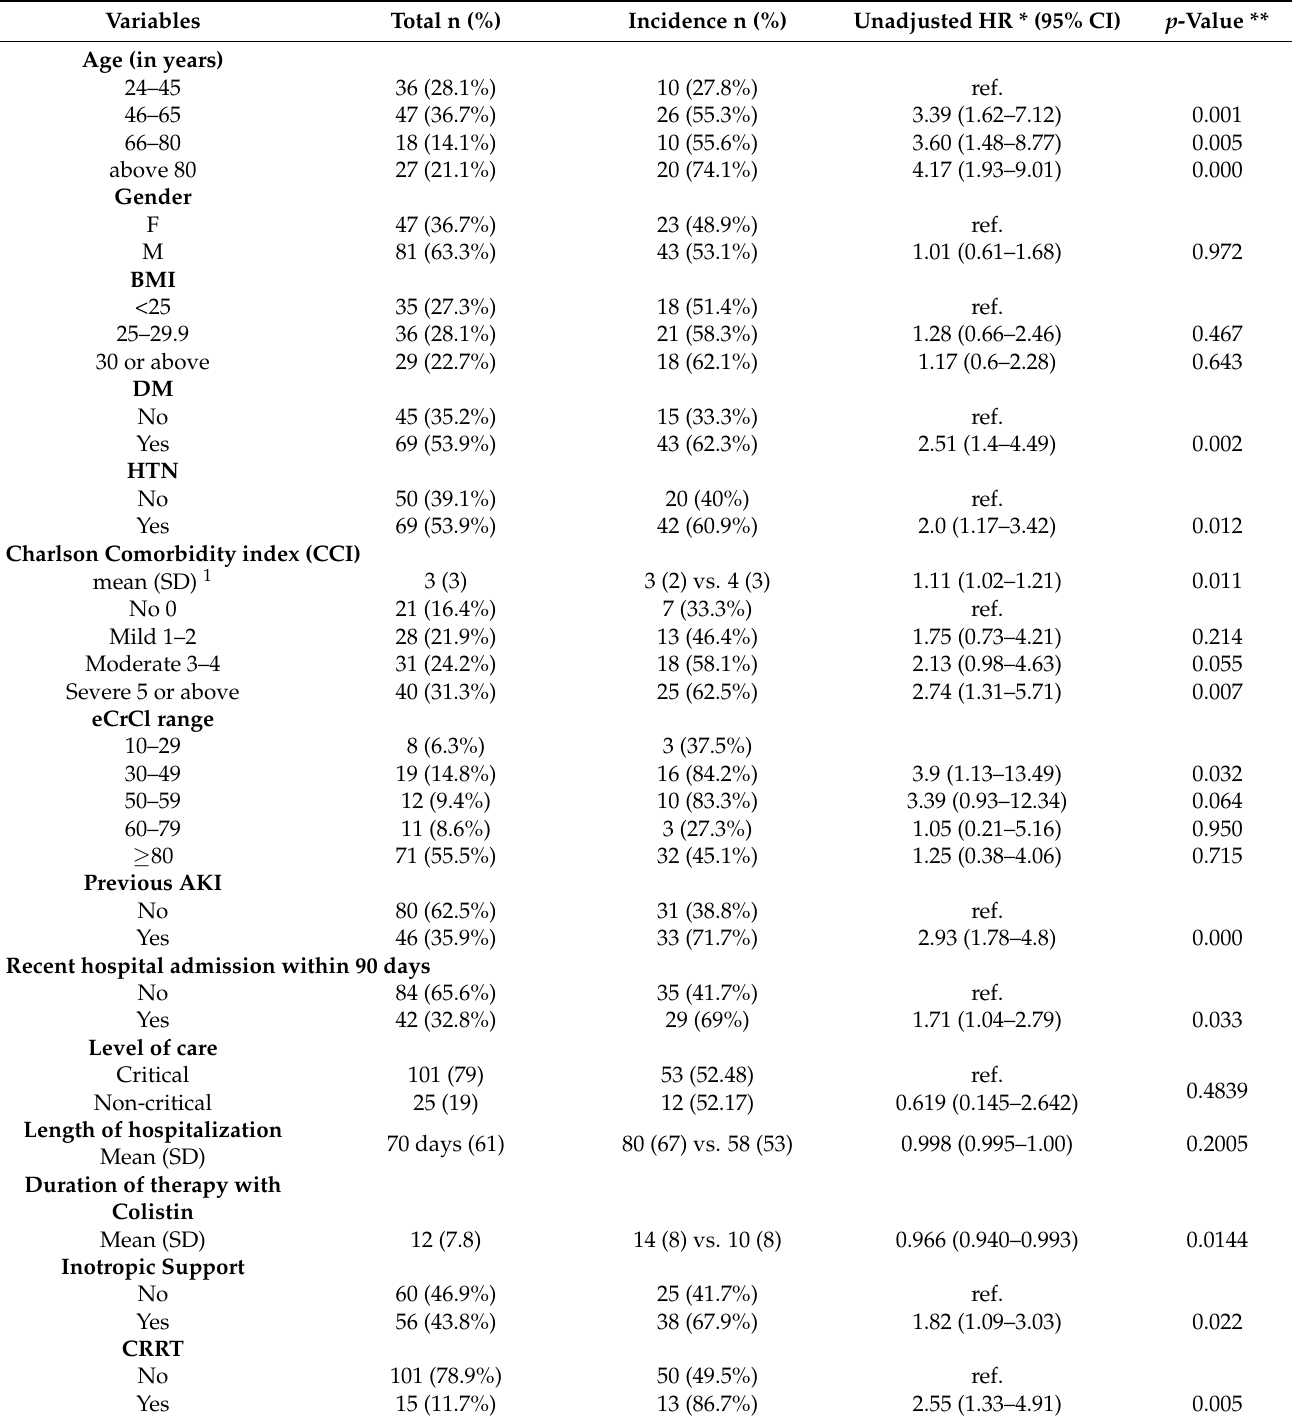
Table 1. Baseline characteristics of study patients and incidence of